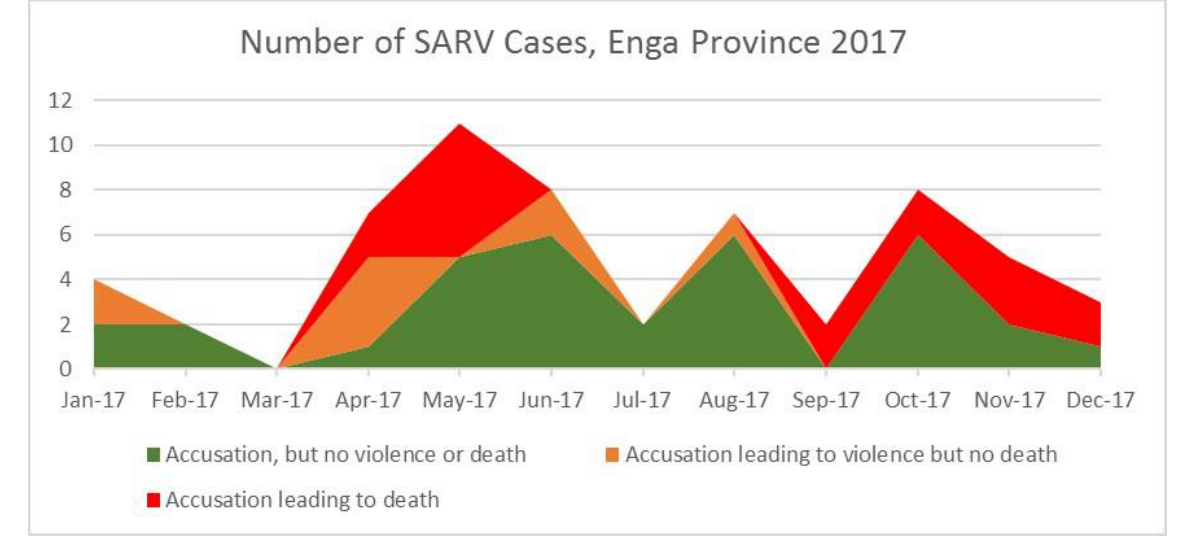
Figure 1: Timeline showing number of SARV cases 2016 – 2018.